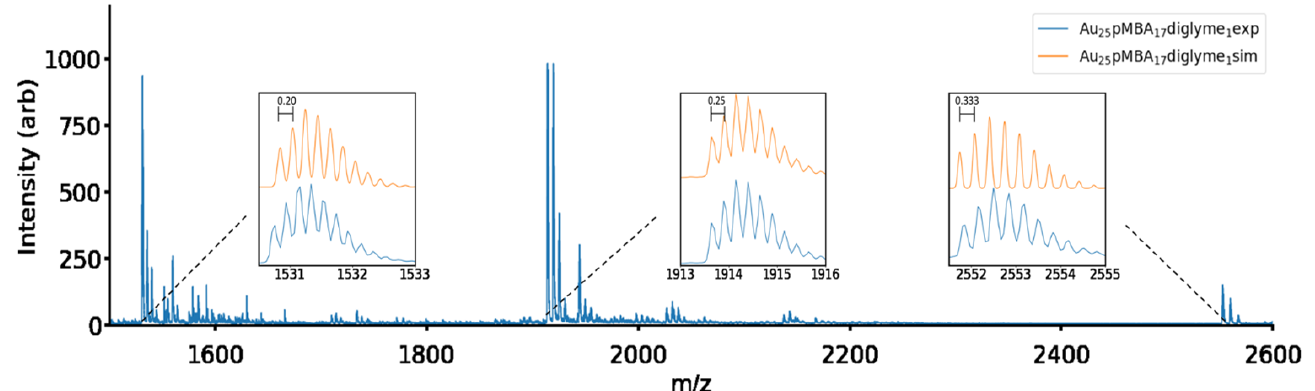
Figure 1. ESI-MS spectra Au 25 pMBA 17 diglyme, with nine protonated carboxylic acid groups, and eight deprotonated, shows three peak groupings. The peak spacing indicates charge states of −5, −4, and −3, respectively. All three parent peaks can be explained by a Au 25 pMBA 17 diglyme cluster. Subsequent peaks relate to sodium adducts of the cluster through the carboxylic ligand group.